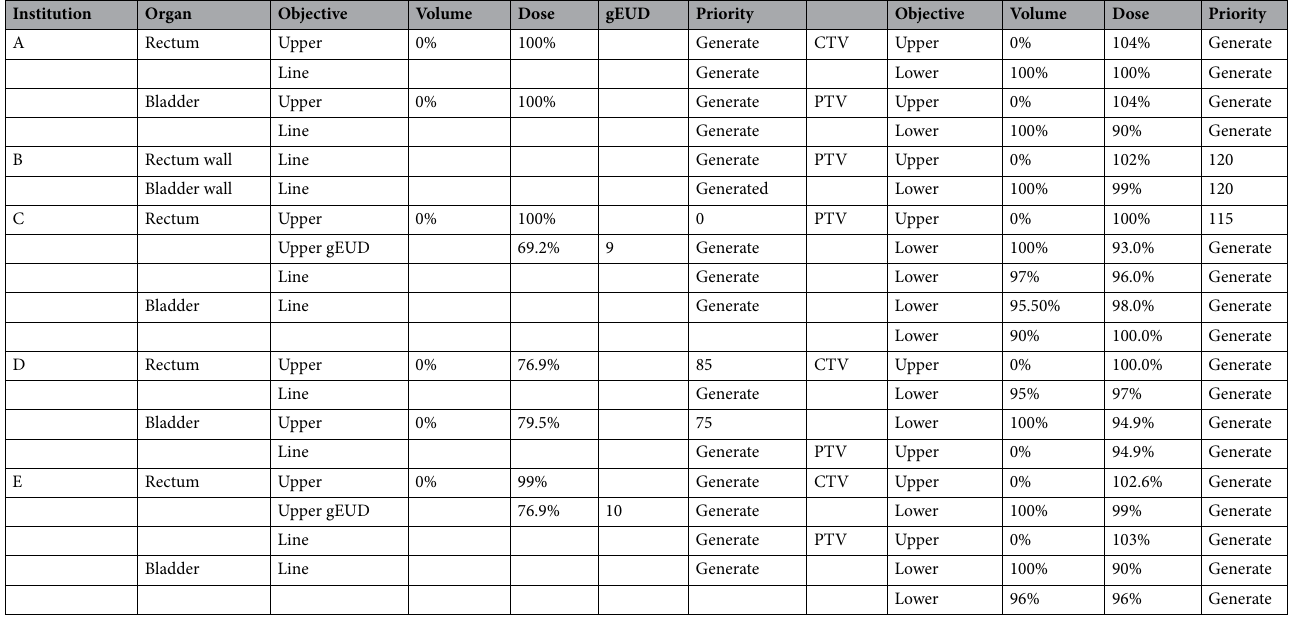
Table 2. Objective settings for optimization with the big model and each single-institution model. gEUD Generalized equivalent uniform dose; CTV Clinical target volume; PTV Planning target